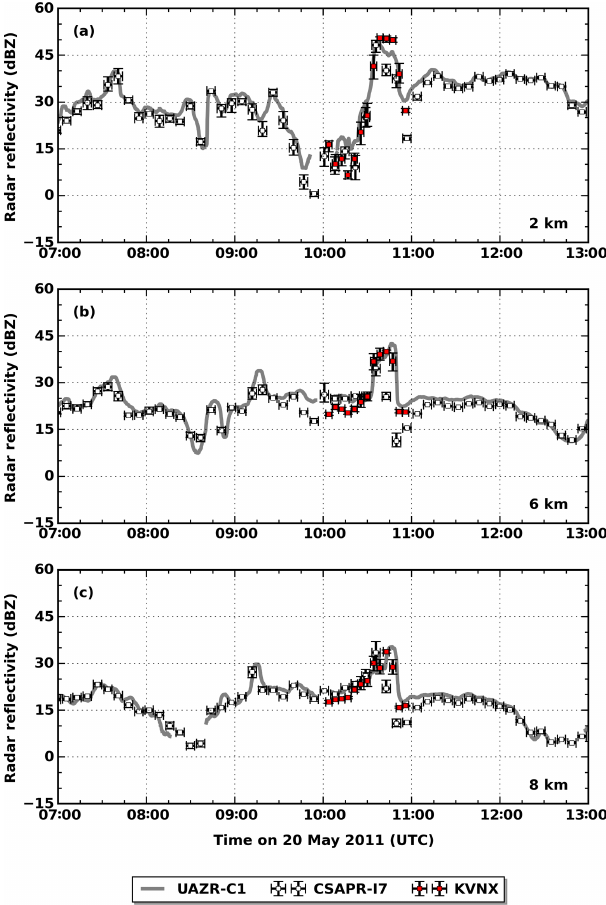
Figure 7. Radar reflectivity observations on 20 May 2011 at three characteristic heights: (a) 2km, (b) 6km, and (c) 8kma.g.l. CSAPR-I7 and KVNX error bars indicate the full range of radar reflectivities within R s and the volume scan time (valid time). UAZR-C1 observations have been filtered using a 61 × 7 time– height median filter. KVNX observations are shown between 10:00 and 11:00UTC,